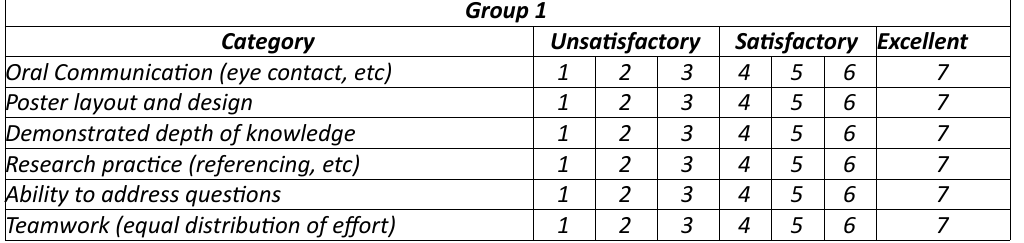
Table 3. Sample Judges Grading